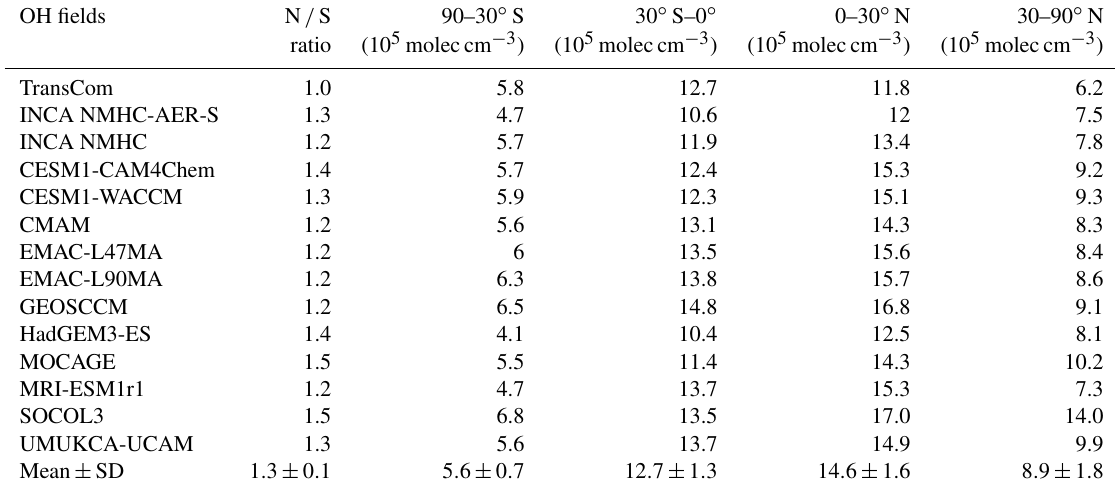
Table 3. Inter-hemispheric ratios (N / S) of hemispheric mean OH and volume-weighted tropospheric mean [OH] for four latitude bands (10 5 moleccm − 3 ) averaged over the years 2000 to 2010. Multi-model means and standard deviations (mean ± SD) are also shown. OH